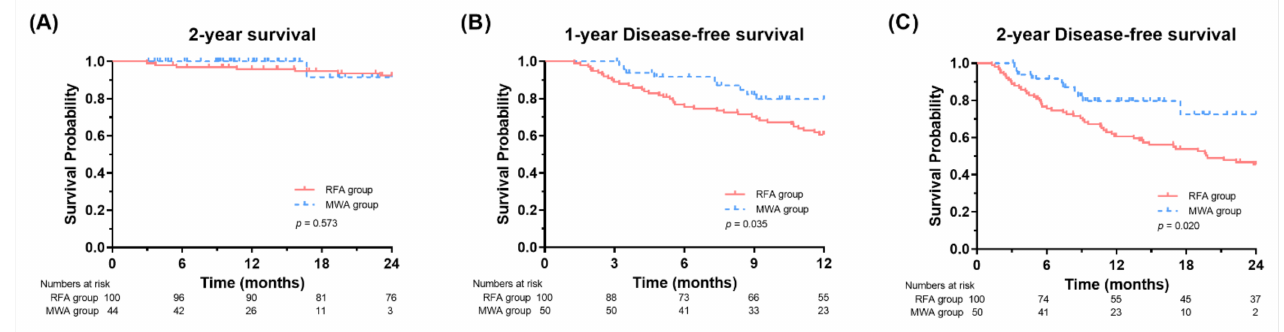
Figure 1. Survival and disease-free survival curves according to the treatment modalities in the entire